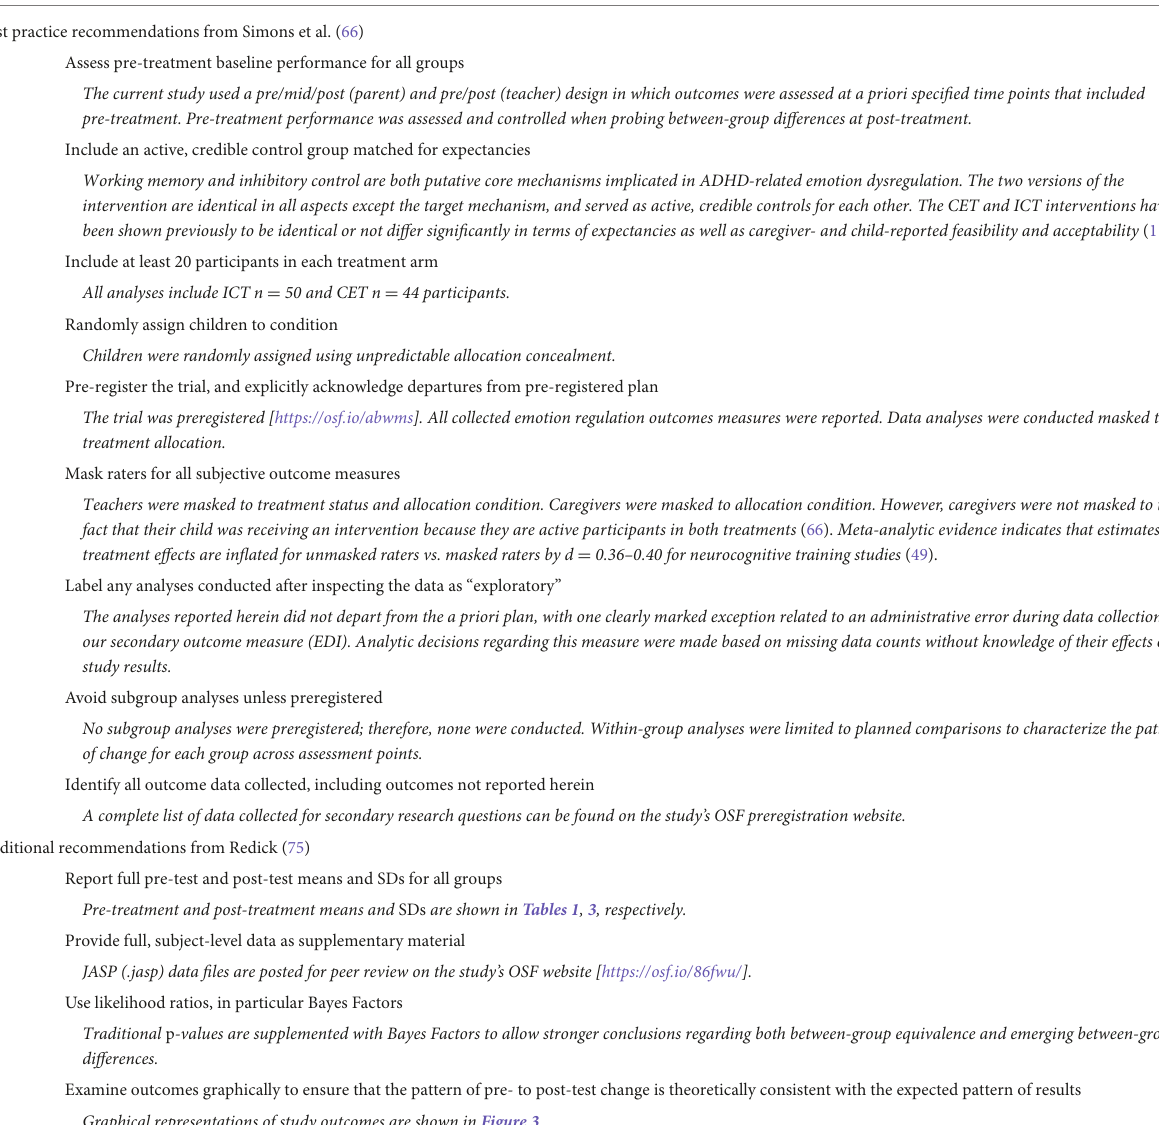
TABLE 2 Critical evaluation of the current study relative to best practice guidelines for cognitive training methodology and reporting standards [adapted from (66) and (75)]. Criterion/